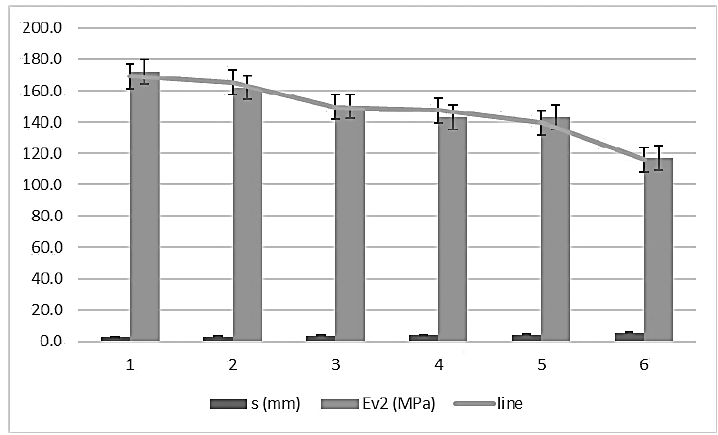
Figure 6. Error bars for topographic settlement and second modulus of PLT ( ɸ 600mm).